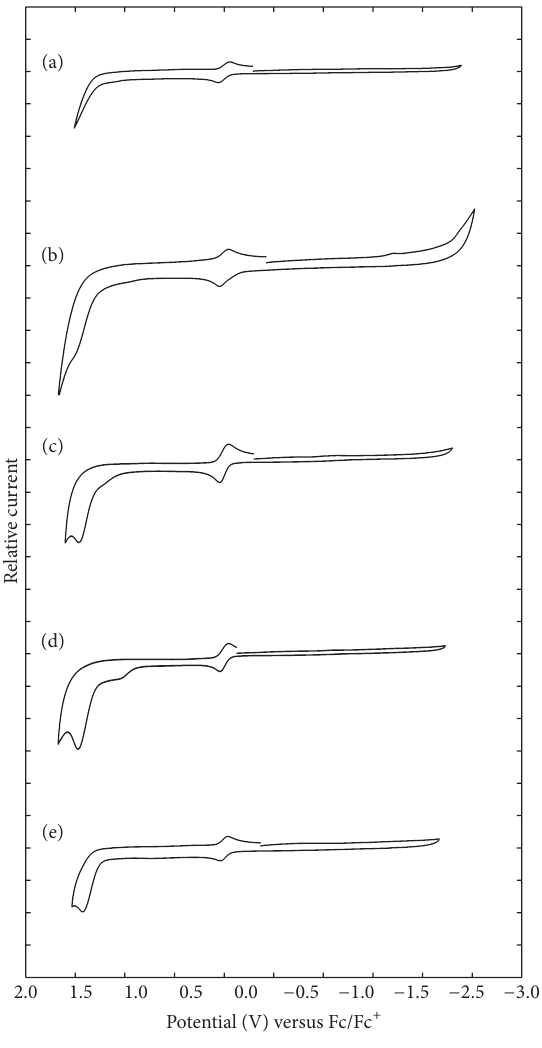
Figure 2: The cyclic voltammograms of porphyrin derived SWNTs and C 20 -SWNTs in the presence of ferrocenes in CH 2 Cl 2 solution using [( t -Butyl) 4 N] + [ PF 6 ] − as supporting electrolyte. (a) Back- ground, (b) THHP-HHP-SWNTs , (c) THHP-HMP-SWNTs , (d) -SWNTs . THHP ⋅ SWNTs , and (e) C 20